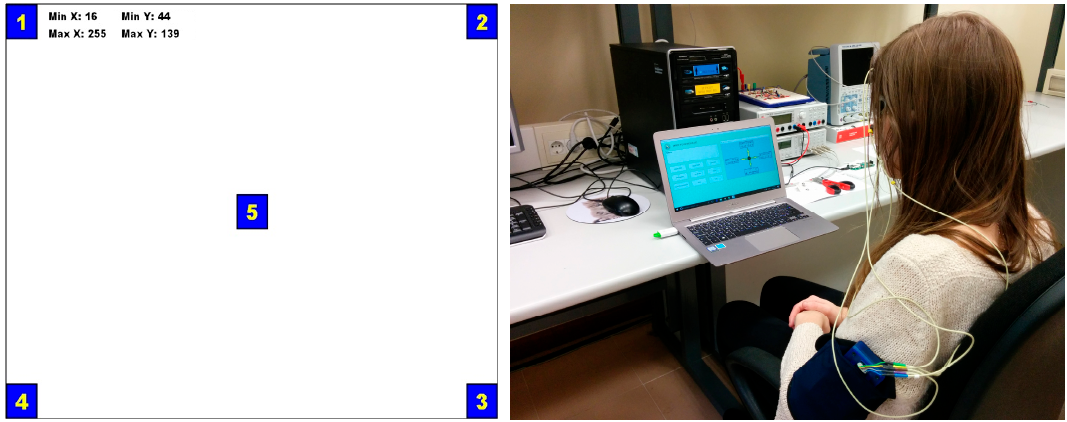
Figure 13. ( a ) Screen to calibrate the application; ( b ) Image of the user arrangement.